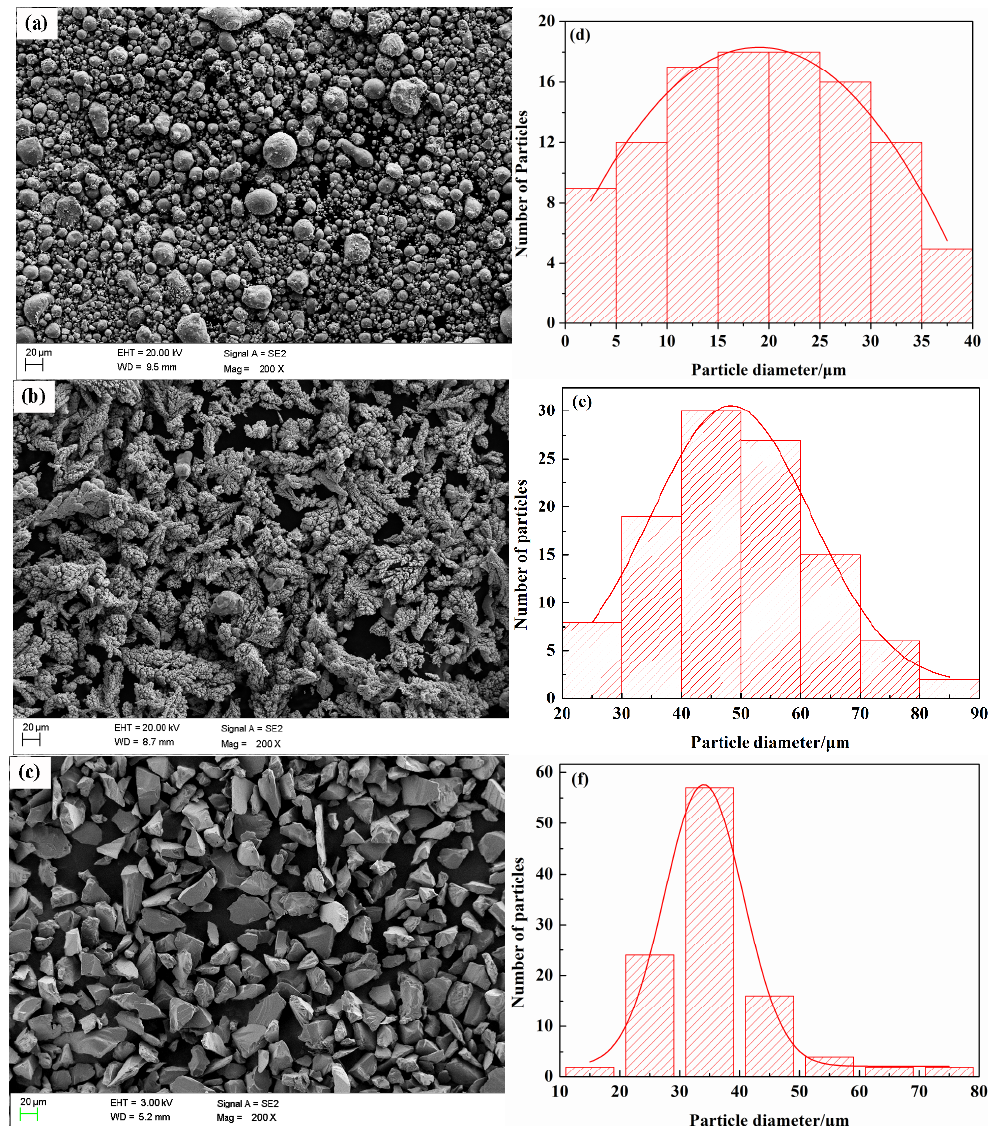
Figure 1. SEM images of the spraying powders: ( a ) Zn, ( b ) Ni and ( c ) alumina and particle size analysis of powders: ( d ) Zn, ( e ) Ni and ( f ) alumina.